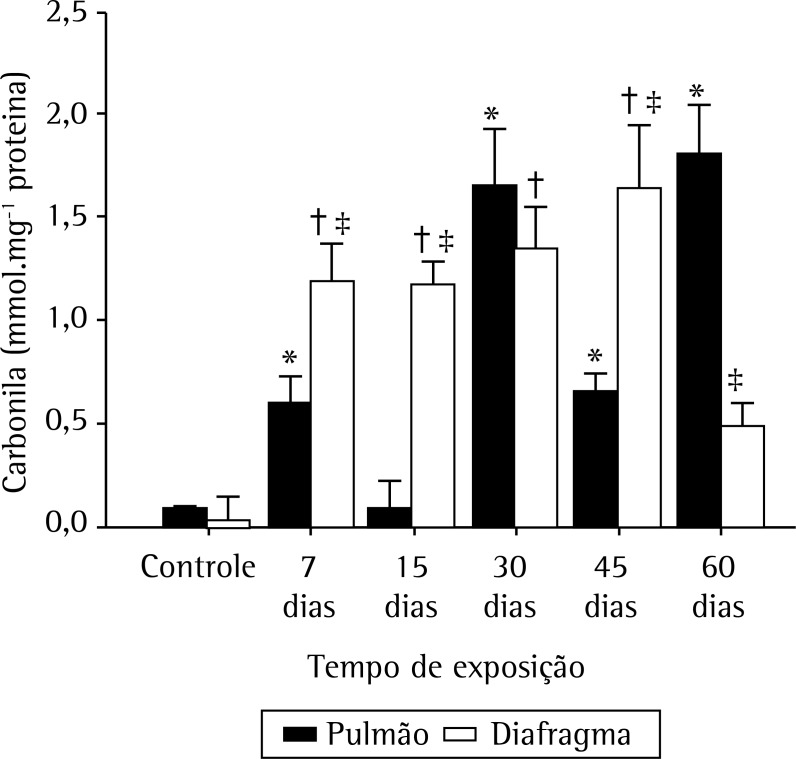
Média ± EPM dos níveis de carbonilas no tecido pulmonar e no músculo
diafragma em 6 grupos de camundongos: grupo controle e 5 grupos expostos a
fumaça de cigarro por 7, 15, 30, 45 e 60 dias, respectivamente. p < 0,05
vs. controle no tecido pulmonar. † p < 0,05 vs. controle no músculo
diafragma. ‡ p < 0,05 vs. tecido pulmonar.